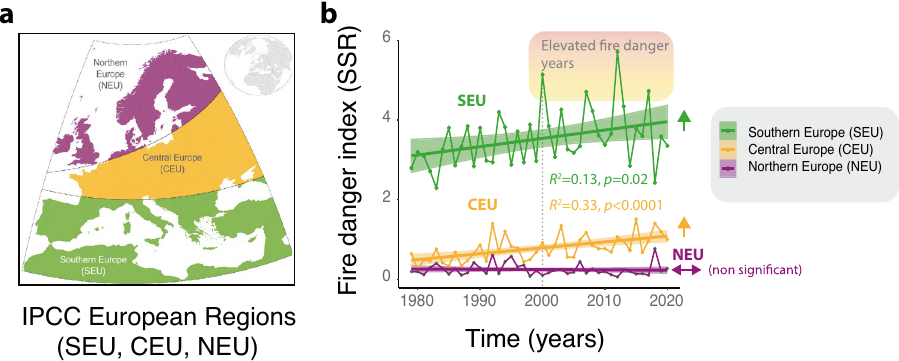
Figure 1. Fire weather dynamics in European IPCC regions. ( a ) A map summarising the distribution of the IPCC regions analysed. The map was produced using QGIS v3.16 (see “Methods”). ( b ) Observed trends in the Seasonal Severity Rating index (SSR) in Southern, Central and Northern Europe over 1980–2019. Colored shaded areas highlight years characterized by higher SSR values over the analyzed period. Ordinary least squares fits are